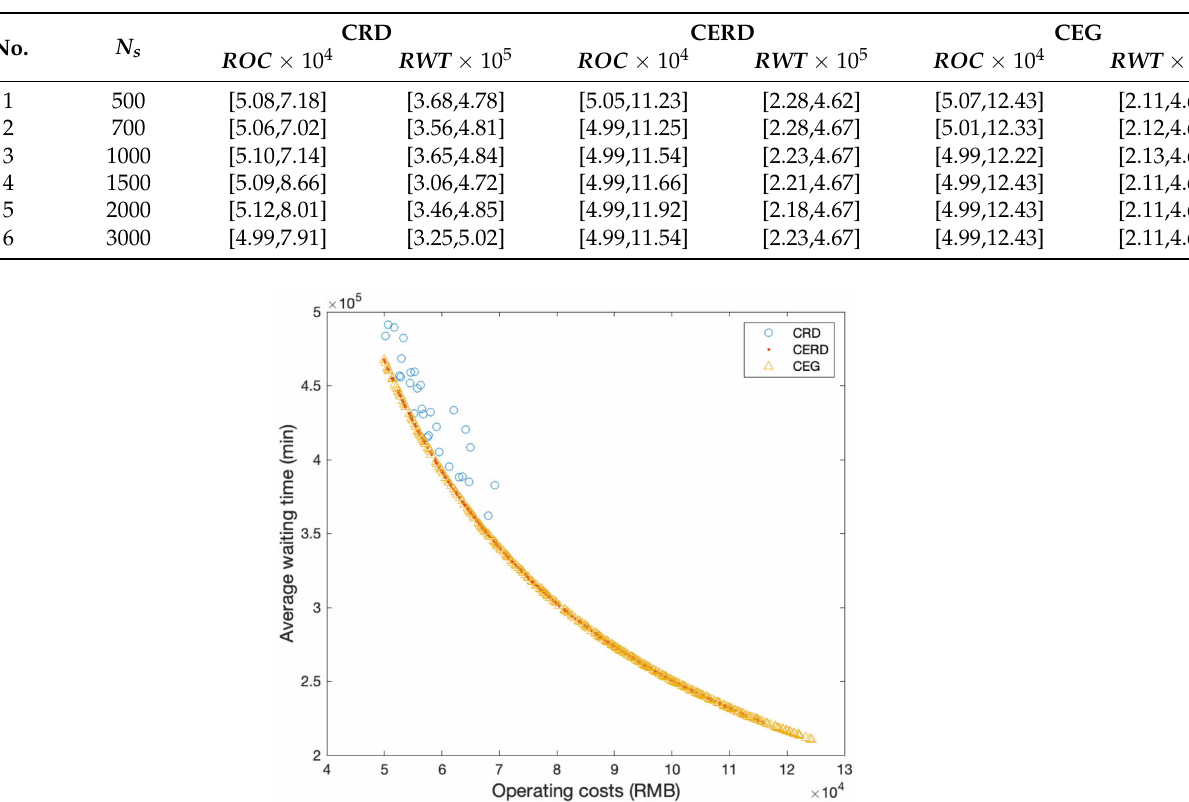
Table 5. The range of the objective function values by different algorithms.